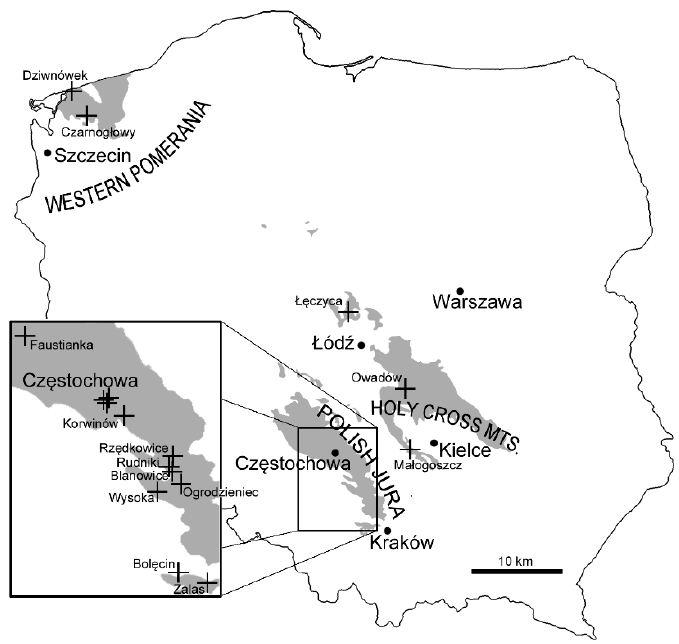
Figure 4. Distribution of Jurassic deposits in Poland, with location of outcrops mentioned in the text.